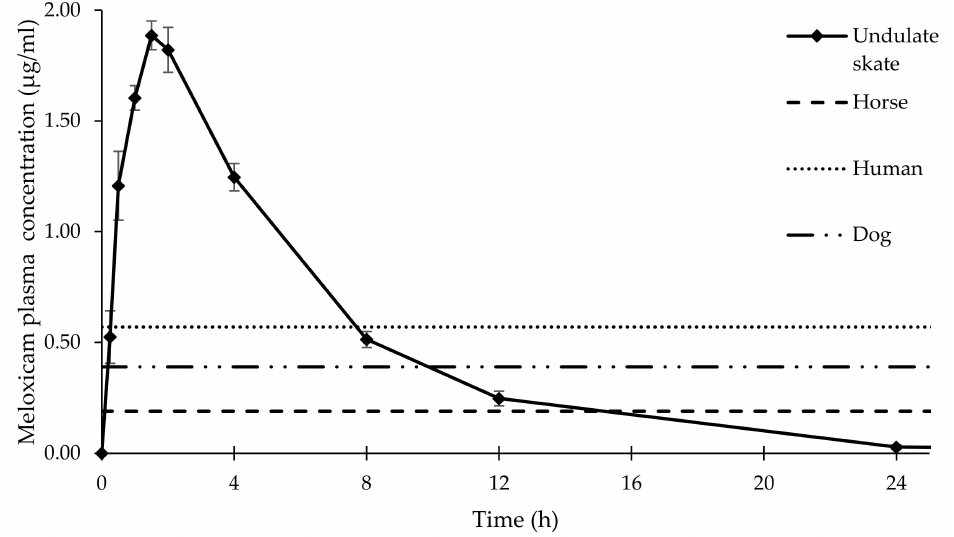
Figure 2. Mean plasma concentrations ± SEM of meloxicam 1.5mg/kg IM in undulate skates ( Raja undulata ) (n = 7). Reference meloxicam concentrations required for anti-inflammatory effect in different animal species are also represented [23–25]. Please note that mean meloxicam concentrations are maintained over inhibitory concentrations (IC) determined for other animal species for 8–12 h after IM administration. Meloxicam plasma concentration at 48 h was under the limit of detection in all